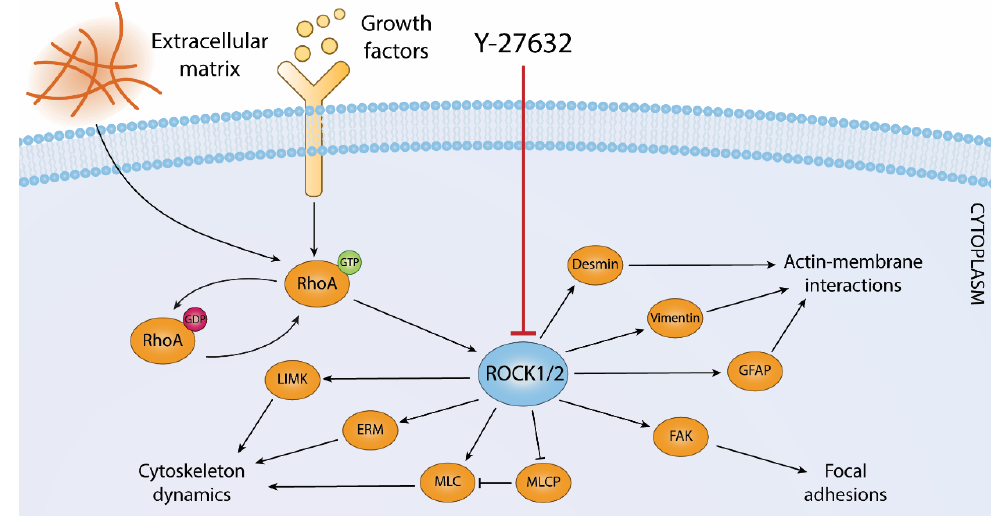
Figure 2. ROCK signaling in the regulation of cytoskeleton structure and